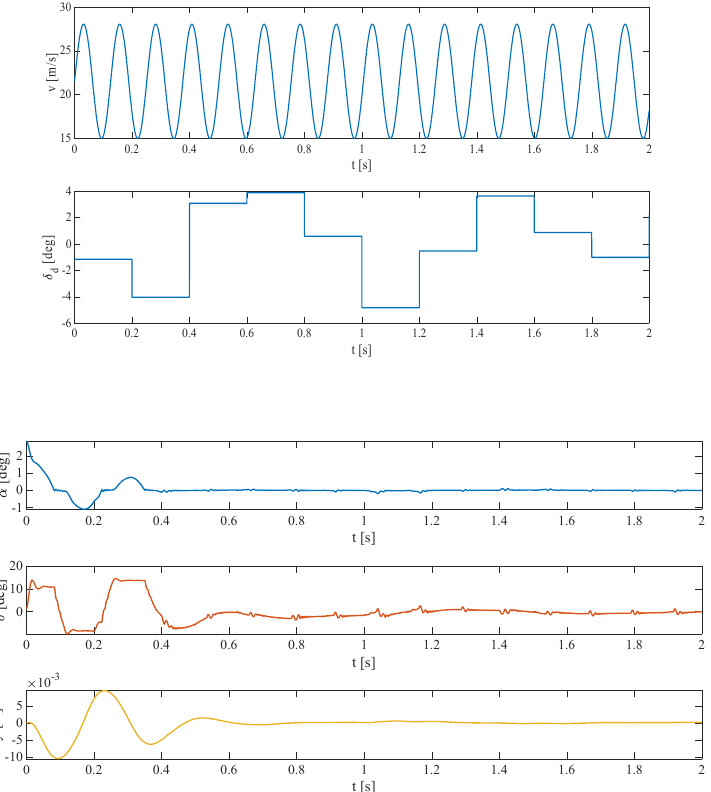
Figure 19. Responses to the sinusoidal velocity variation and random disturbance.